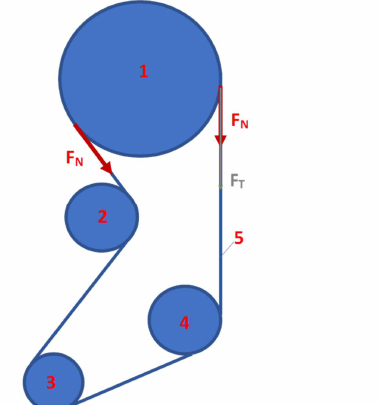
Fig. 7. Forces from the toothed belt loading the timing pulley. 1 – toothed pulley on the camshaft, 2 – tensioner, 3 – toothed pulley on the crankshaft, 4 – toothed pulley on the water pump shaft, 5 – toothed belt. F N – force from the toothed belt tension, F T – force resulted from the part of